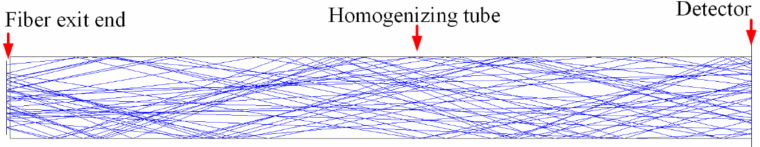
Figure 6. Schematic diagram of direct coupling between optical fiber and homogenizing